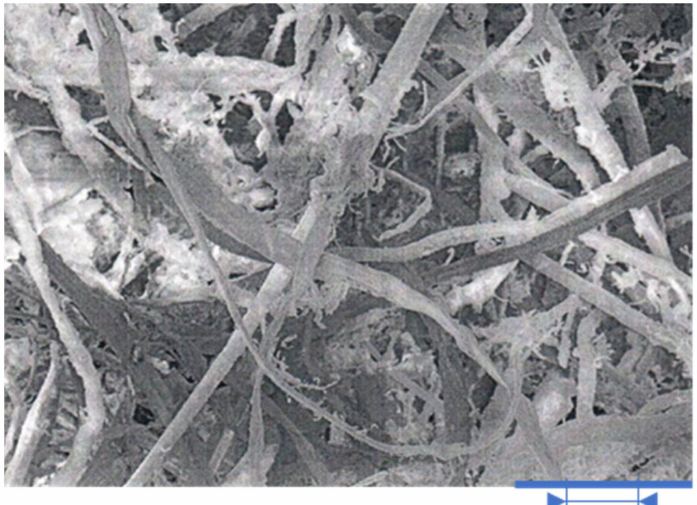
Figure 1. Light microscopy images of straw fibers with magnification 200 × . Legend: Blue line presents a size of 100 microns ( µ m) in 2D